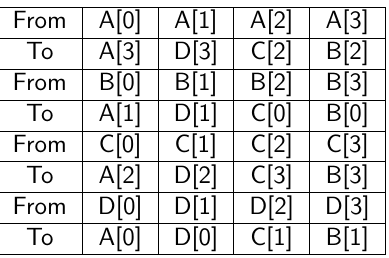
Figure 1: 2-Round AESQ